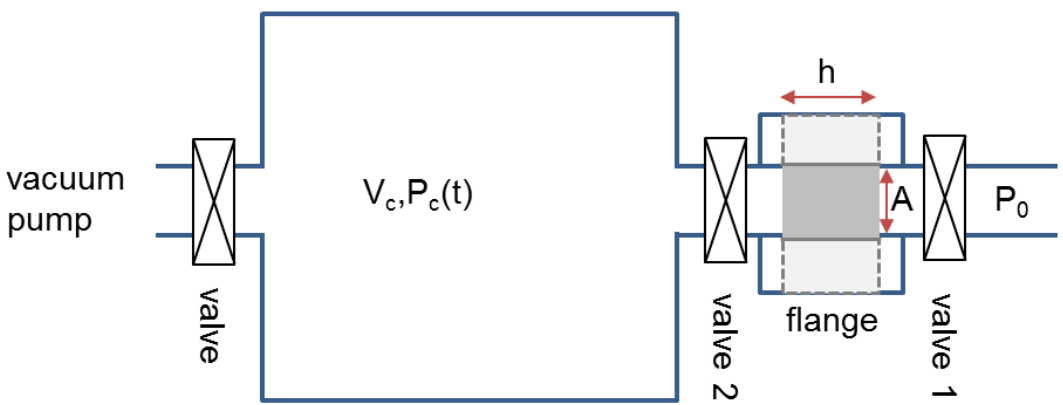
Figure 8. Experimental setup to measure the gas permeability. The samples had the thickness h and cross-sectional area A .